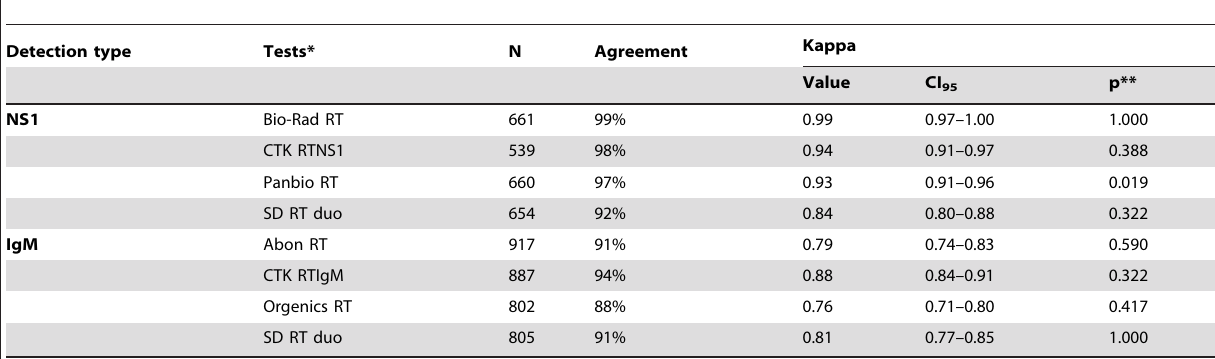
Each test (anti-DENV IgM rapid test (RT) and the DENV NS1 antigen RT) was read and recorded independently by two operators. The agreement between the operators was reflected as kappa values. *Each test was read and recorded independently by two operators. **McNemar